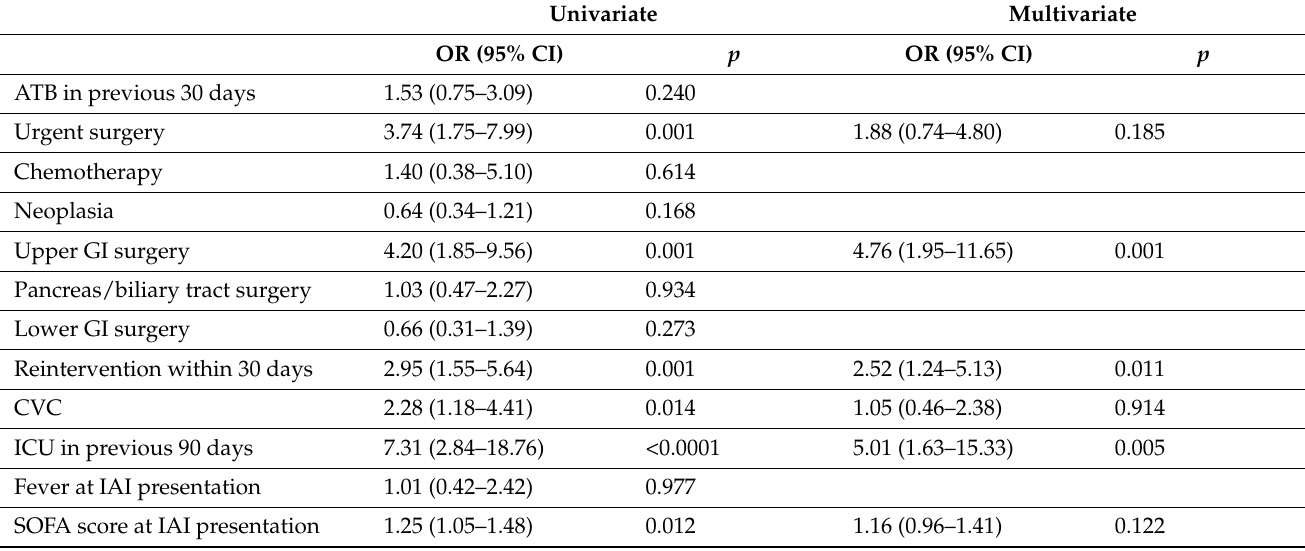
Table 2. Factors associated with the administration of empiric antifungal therapy. Univariate